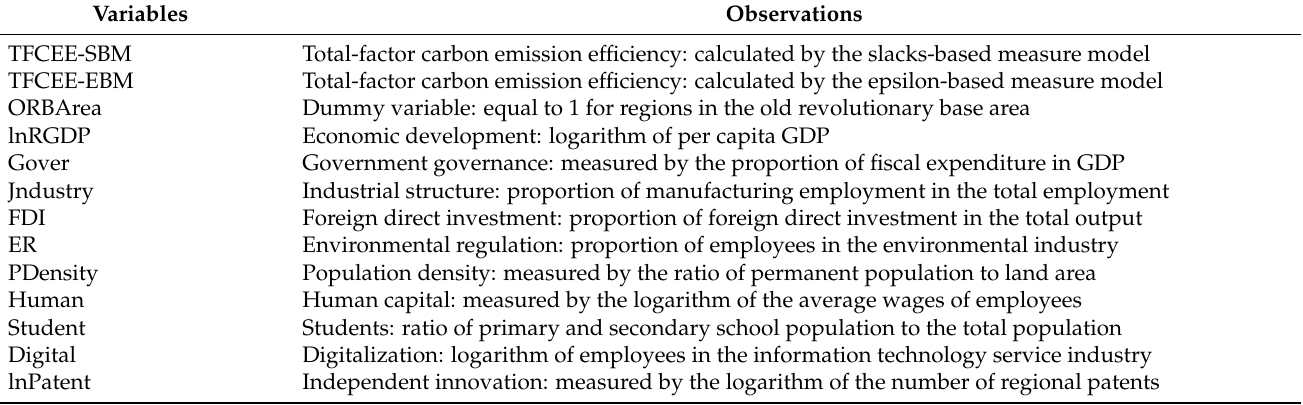
Table 1. Variable definitions.